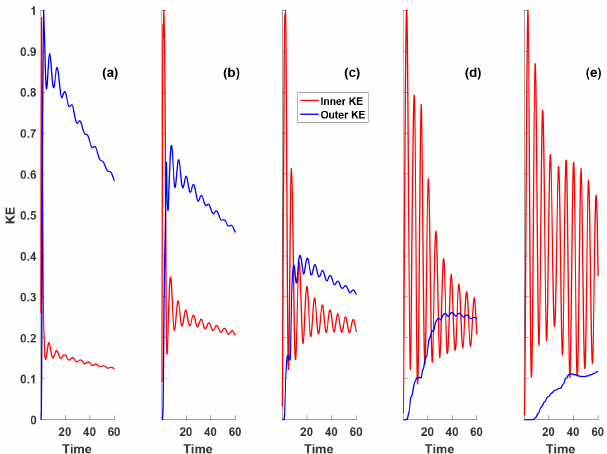
Figure 12. The total kinetic energy located inside (blue) and outside (red) of the geostrophic state. In this figure we have the same cases as in Figs. 10 and 11, separated into their own panels. Panel (a) w 0 ( Ro = 2), (b) corresponds to 1 w 0 ( Ro = 1), (c) corresponds to 1 4 2 corresponds to w 0 ( Ro = 0 . 5), (d) corresponds to 2 w 0 ( Ro = 0 . 25), and (e) corresponds to 4 w 0 ( Ro = 0 . 125). The red line (inner) is the energy inside the geostrophic state, while the blue line (outer) corresponds to that